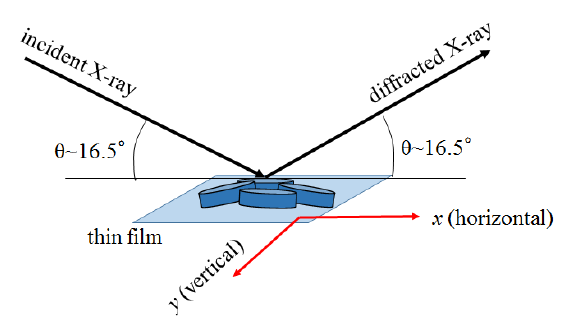
Figure 5. Schematic configuration of